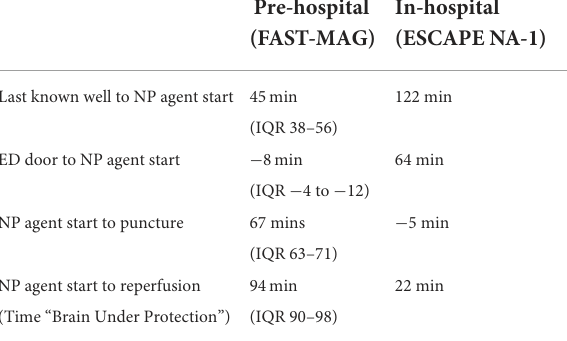
TABLE 2 Time interval results with pre-hospital vs. in-hospital neuroprotective